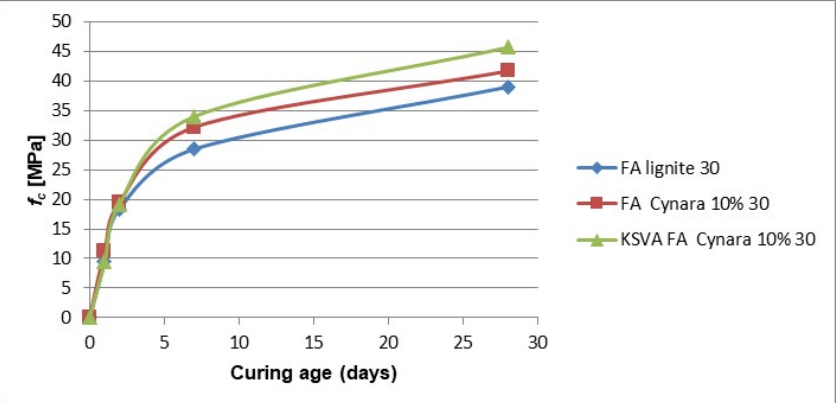
Figure 21. Comparison of strength development for 10% thermal share of Cynara fly ash from KSVA with industrial fly ashes to include 10% thermal share of Cynara, with 30% cement substitution; FA = fly ash.